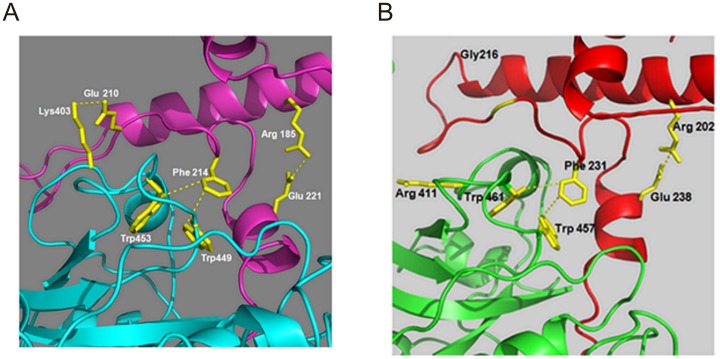
Predicted interactions between the prodomain and the mature domain of FP2 and FP3.
A. Close up of predicted interactions between the mature enzyme and the ERFNIN and GNFD motifs of the prodomain (Arg 185 - Glu 221, and Phe 214-Trp449/Trp 453, Glu 210 - Lys 403). Blue dashed lines indicate presumed stabilizing interactions between residues in FP2. B. Blue dashed lines indicate presumed stabilizing interactions (Arg 202-Glu238 and Phe 231-Trp457/Trp461) between the residues in FP3.